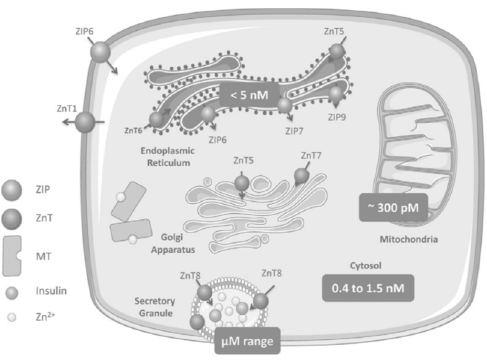
Figure 2. Zinc homeostasis in pancreatic beta cells includes multiple ZnT and ZIP transporters with ZnT8 transporters specific to the ISGs of pancreatic cells [9].